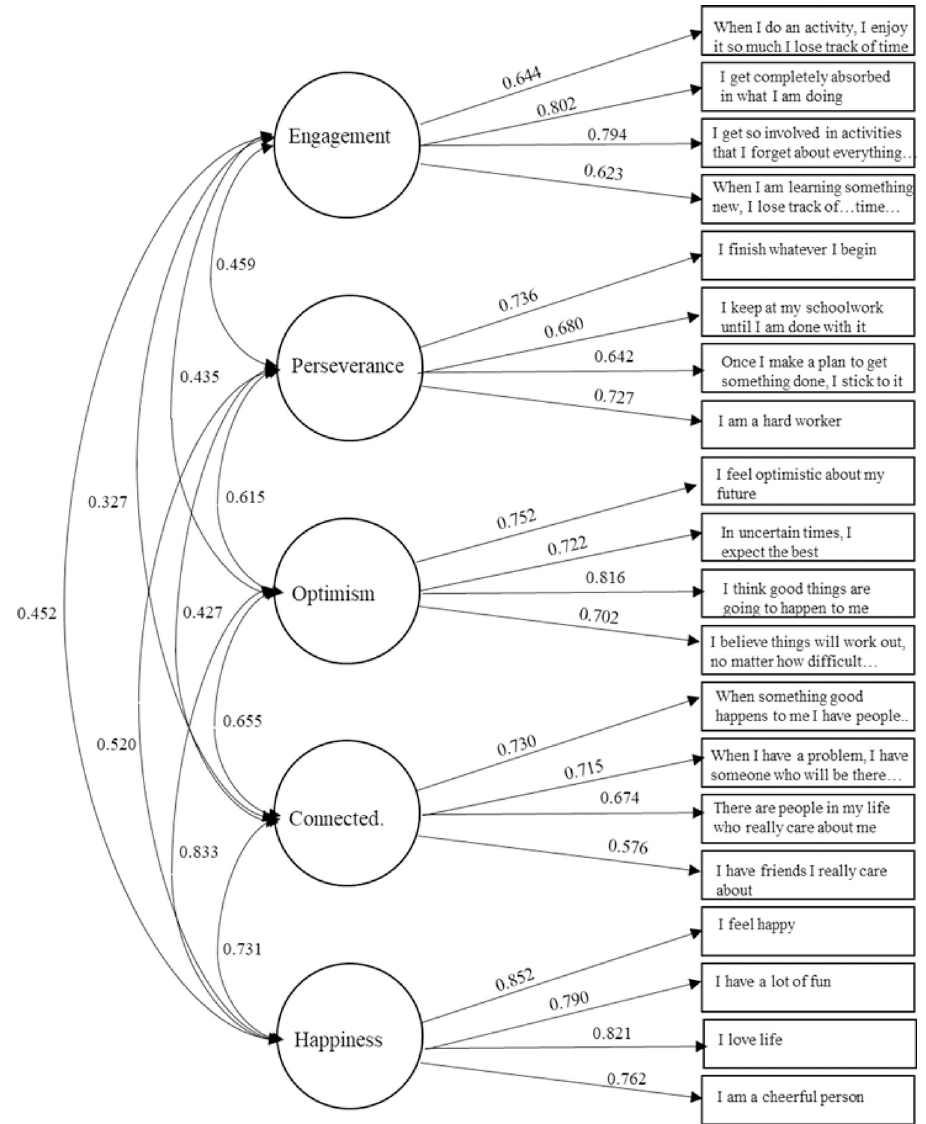
Fig 1. Confirmatory factor analysis of the EPOCH item loadings onto their subcomponents, showing the standardized factor loadings and latent correlations (some items are abbreviated).